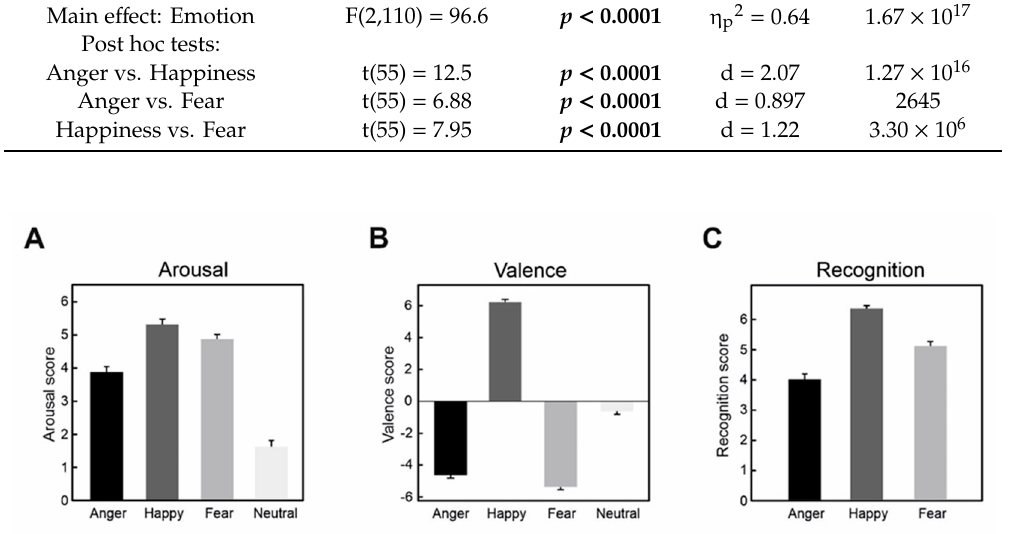
Figure 1. ( A ) Arousal scores for each facial expression. ( B ) Valence scores for all facial expressions. ( C ) Recognition scores of anger, happiness, and fear for the corresponding pictures of angry, happy, and fearful faces. Error bars depict standard error of the means.